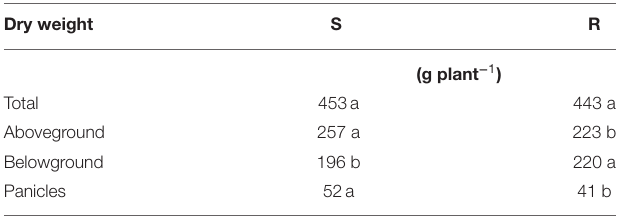
TABLE 2 | Total dry weight and dry weight of different plant parts (aboveground, belowground and panicles) of Exp3 in relation to the resistance status: susceptible (S) and resistant (R) to ACCase